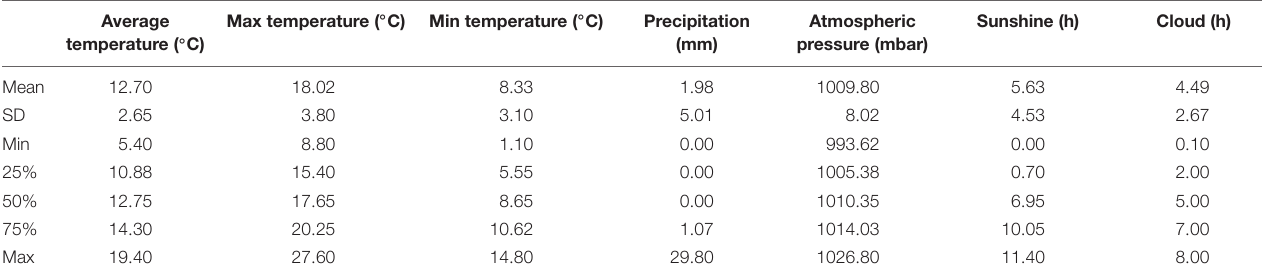
TABLE 1 | Details of the weather variables with mean, standard deviation (SD), minimum and maximum values (and percentiles); mm (millimeter), hrs. (hours), mbar (millibar), C (degrees Celsius). Average Max temperature ( ◦ C) Min temperature ( ◦ C) Precipitation temperature ( ◦ C)